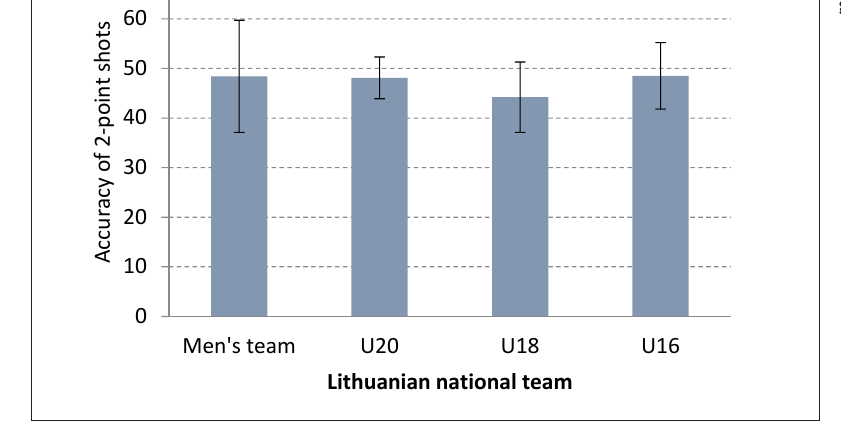
Figure 2. The accuracy of 2-point shots for men’s basketball teams in the European championship matches (average per one game)